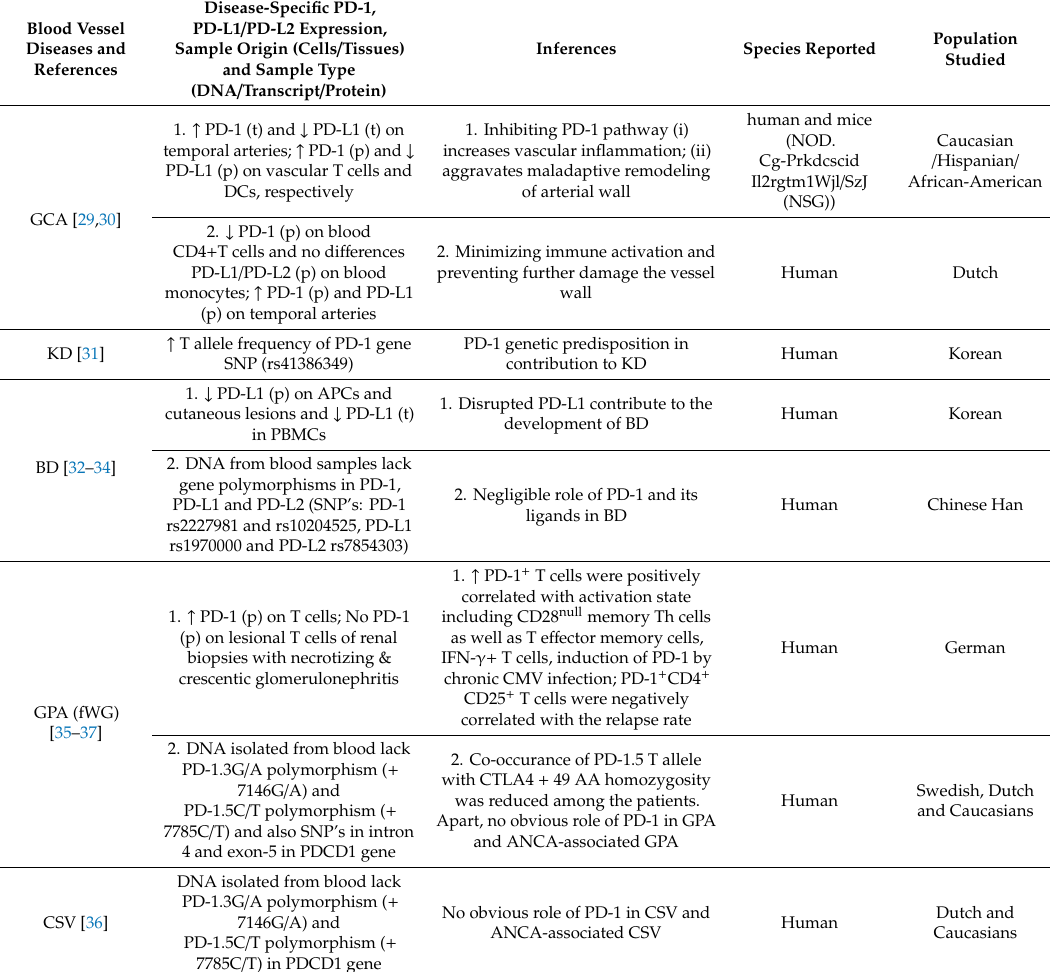
Table 1. Di ff erential Expression of programmed death-1 (PD-1) and its ligands in vasculitides. Blood Vessel Diseases